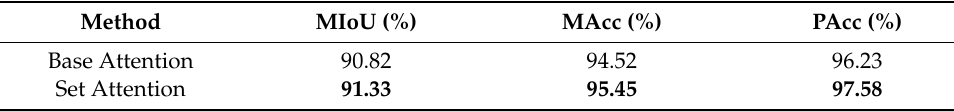
Table 1. Set Attention Block ablation experiment